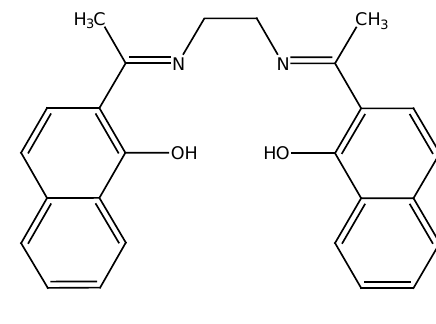
Figure 47. 2,2'-[1,2-ethanediyI bis